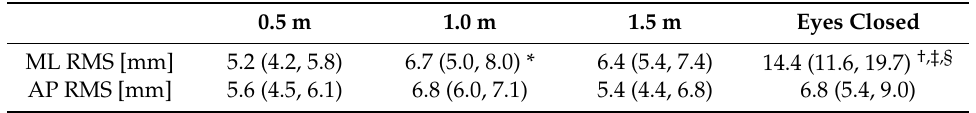
Values are represented as median (interquartile range). * = significance between 0.5 m and 1.0 m conditions, † = significance between the 0.5 m and eyes closed conditions, ‡ = significance between the 1.0 m and eye closed